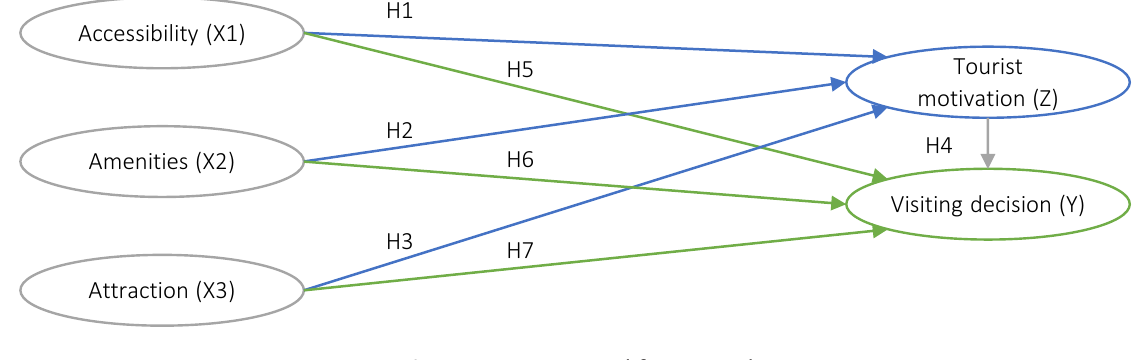
Figure 1. Conceptual